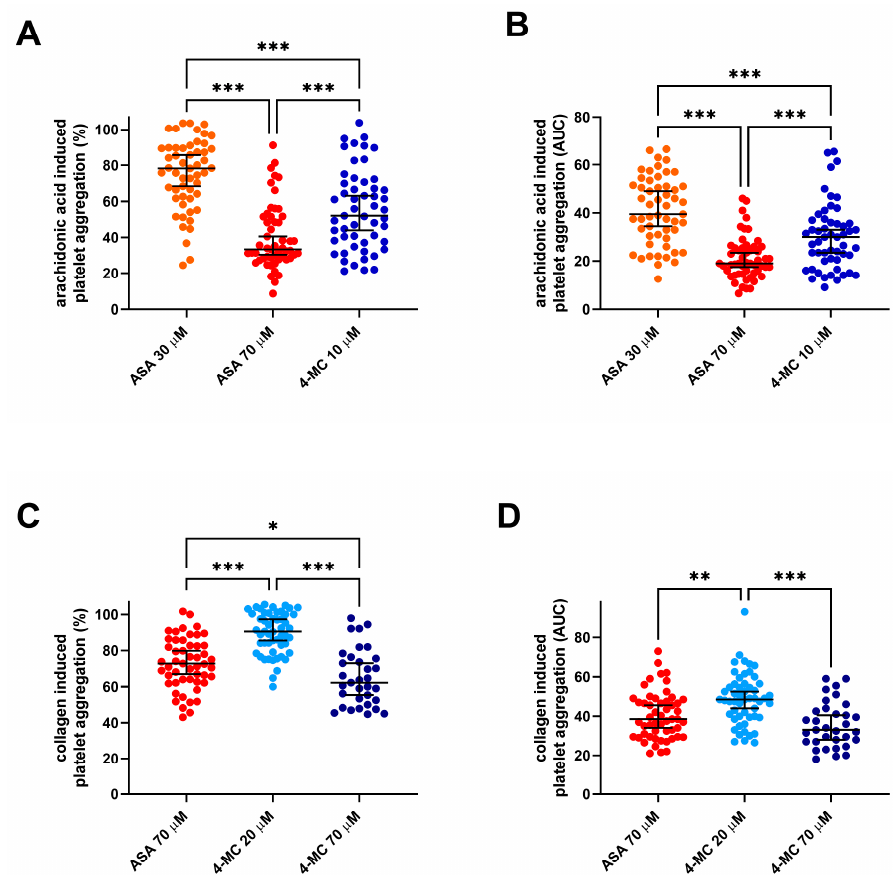
Figure 1. A comparison of the antiplatelet effects of 4-methylcatechol and acetylsalicylic acid on arachidonic acid- and collagen-triggered platelet aggregation. ( A , B ) Aggregation was induced by 200 µ M of arachidonic acid. ( C , D ) Aggregation was triggered by 1 µ g/mL of collagen. ( A , C ) Relative aggregation (each value represents the percent inhibition of platelet aggregation vs. the control sample with dimethyl sulfoxide (DMSO) and the corresponding inducer). ( B , D ) Absolute values measured by the area under the curve (AUC). * p < 0.05, ** p < 0.01, *** p < 0.001. The data are shown as the median ± 95% confidence intervals. ASA—acetylsalicylic acid 4-MC—4-methylcatechol.